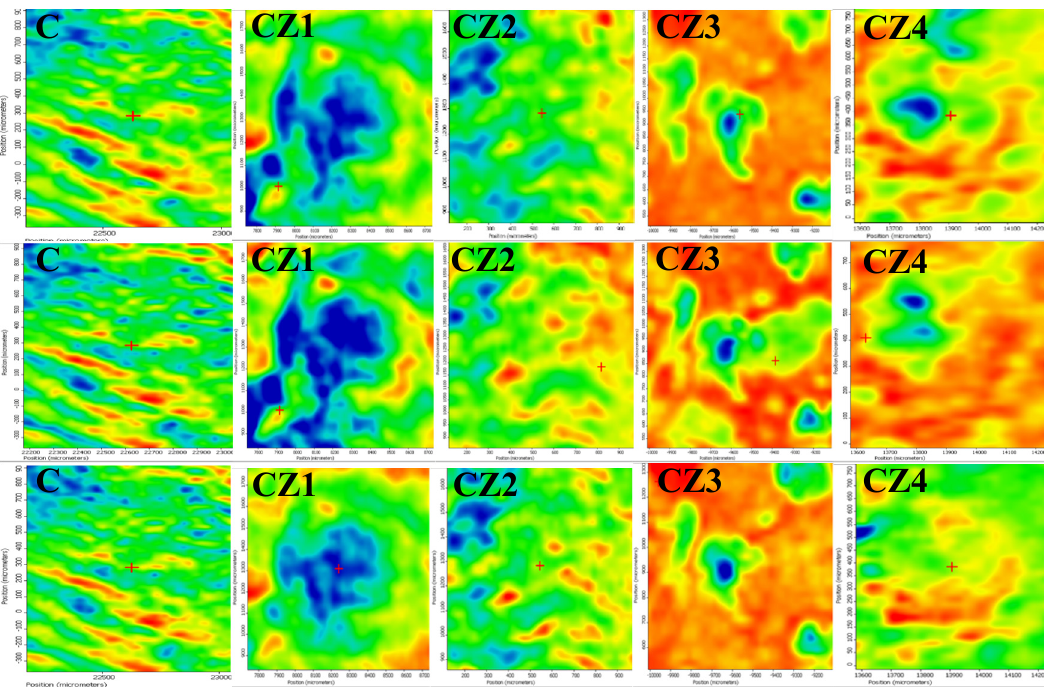
Figure 1. The FTIR maps for CZ1–CZ4 films at wavenumbers 3275 cm − 1 ( top row ); 1743 cm − 1 ( intermediate row ); and 1643 cm − 1 ( bottom row ).